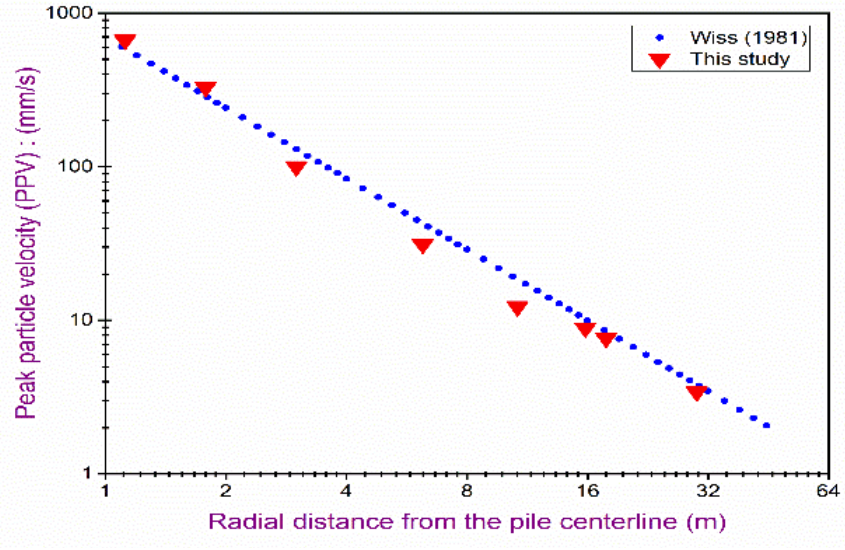
Figure 5. Peak particle velocity (PPV) measurements presented by Wiss [51] and computations caused by driving the pile into soil particles located at the ground surface.